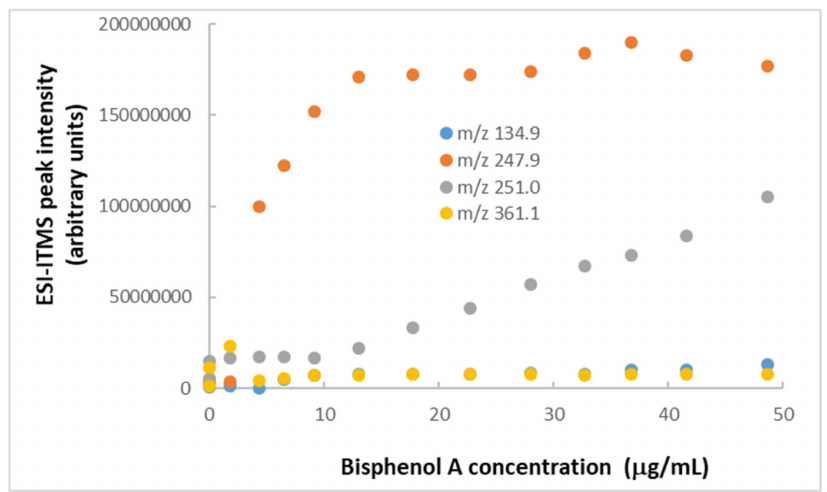
Figure 2. Standard calibration curves from serial dilutions of BPA (100 µ g / mL) in mixtures with TiO 2 nanoparticles (414 µ g / mL) by ESI-ITMS, using extracted ion monitoring of four peaks at di ff erent m / z in positive polarity. Relative standard deviation of each data point =